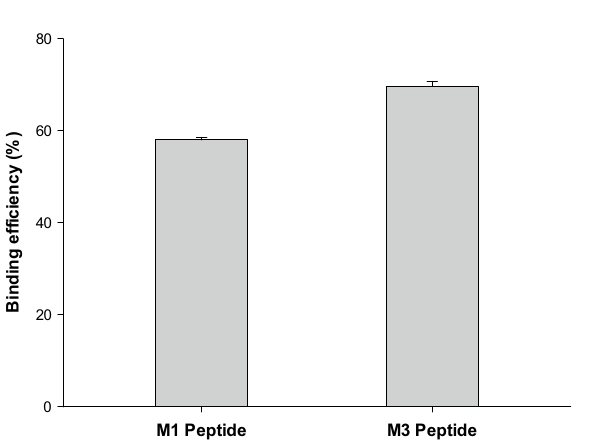
Figure 3. Binding efficiency of two synthesized peptide sequence selected from phage with high affinity to VDBP-Complex. Binding efficiency of two peptide sequences (M1, M3) selected from phage with high affinity to VDBP-Complex. The binding affinity of the phage clones to VDBP-Complex was confirmed through ELISA assay, and a peptide sequence having a high affinity among them was synthesized, and conjugated with magnetic beads. The VDBP-Complex concentration decrease was measured by Bradford assay of the remaining supernatant, after removing the magnetic beads by magnetic